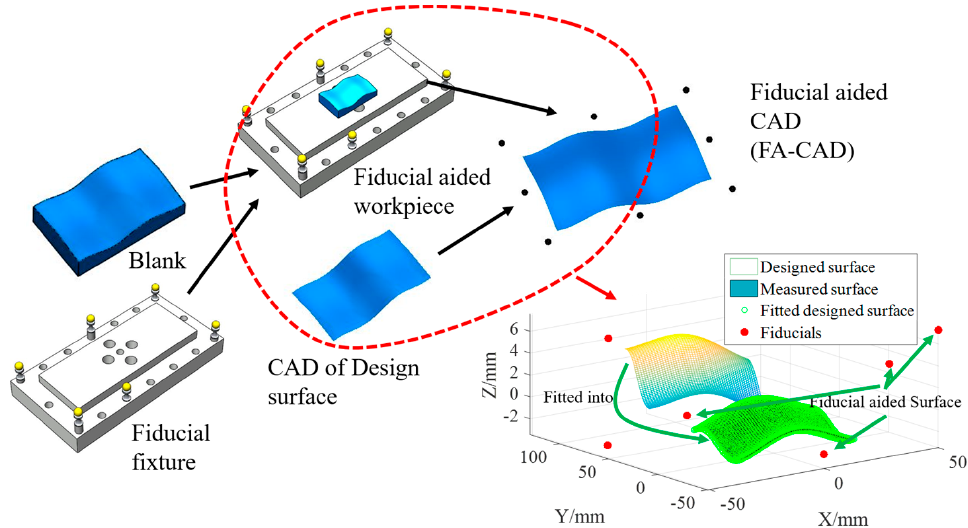
Figure 2. Construction process of the of FA-CAD of the designed surface (DS).